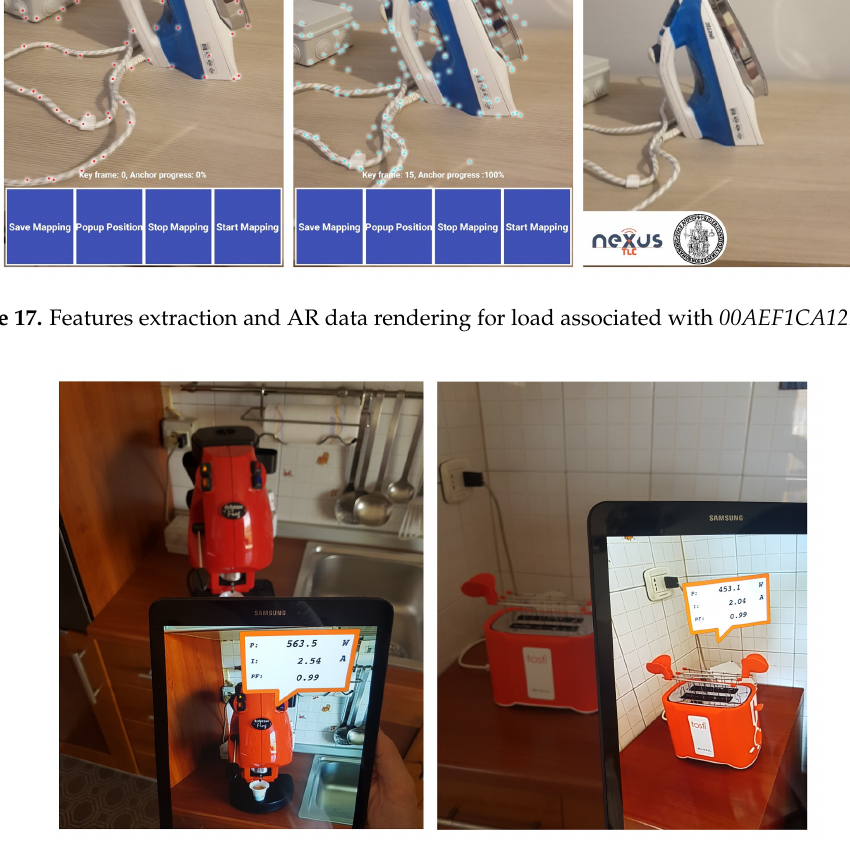
Figure 18. Examples of AR data rendering by means of medium-level